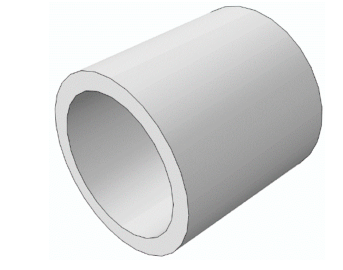
Figure 11. Intact pipe.